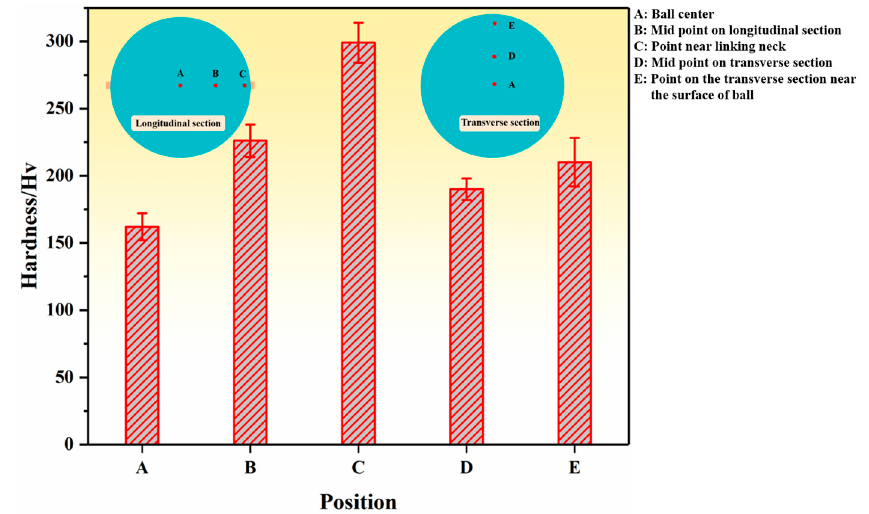
Figure 10. Microhardness of di ff erent positions in steel balls.